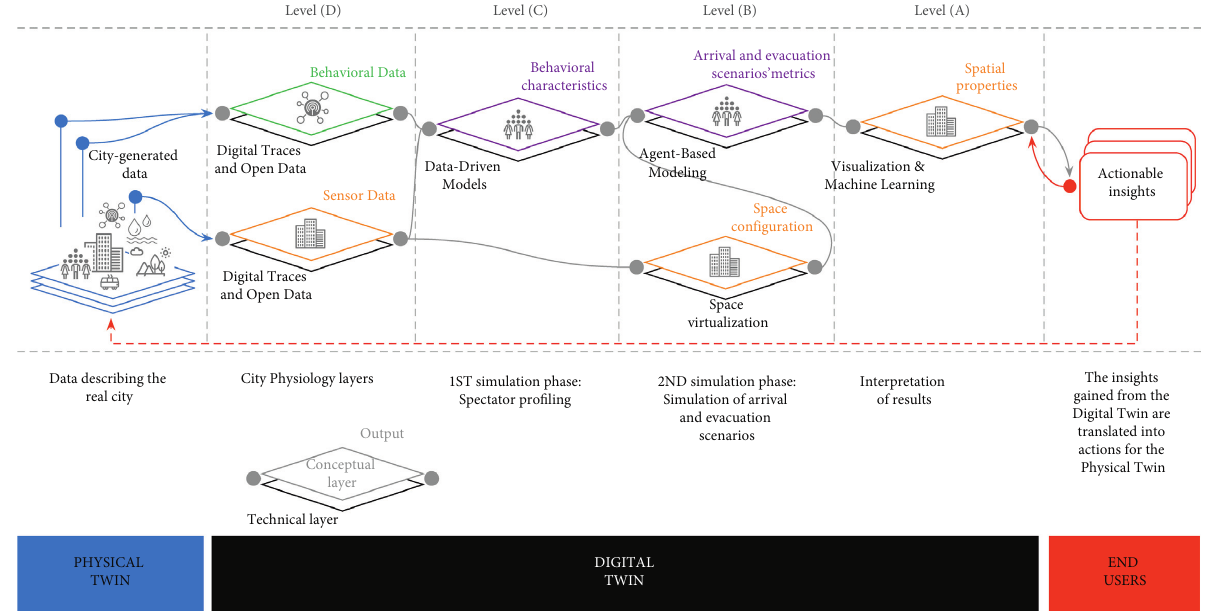
Figure 9: Result of the case study. The diagram shows the structure of the digital twin, and how end users employ it to make informed decisions about possible intervention for the facility management of the physical twin. The digital twin is made of both conceptual and technical layers. In this particular case, the outputs are spatial metrics ( Built Domain ) about the behavior of the crowd ( Society ). If the resulting interpretations are nonactionable or inconclusive, both conceptual and technical layers need to be refactored, and new metrics computed (feedback between end user and digital twin, grey/red arrows). When translated into actions, the insights gained from the digital twin may change the reality of the physical twin (red dashed arrow), leading to a change in the input data (feedback between physical and digital twin, blue arrows). The digital and the physical twins need the intervention and decision-making of the end user to interact; even though the output of the digital twin is targeted at one layer, the actions undertaken may affect others, showing both the complexity of the problem and the sensitivity of the framework. Created using icons from the noun project (https://thenounproject.com - “environment” icon by iconixar, “ecosystem” icon by Kamin Ginkaew, “buildings” icon by Ralf Schmitzer, “Society” icon by David Garc´ıa, “Water” icon by Icongeek26, “Tram” icon by Andrejs Kirma, and “Network” icon by Priyanka) under a CC